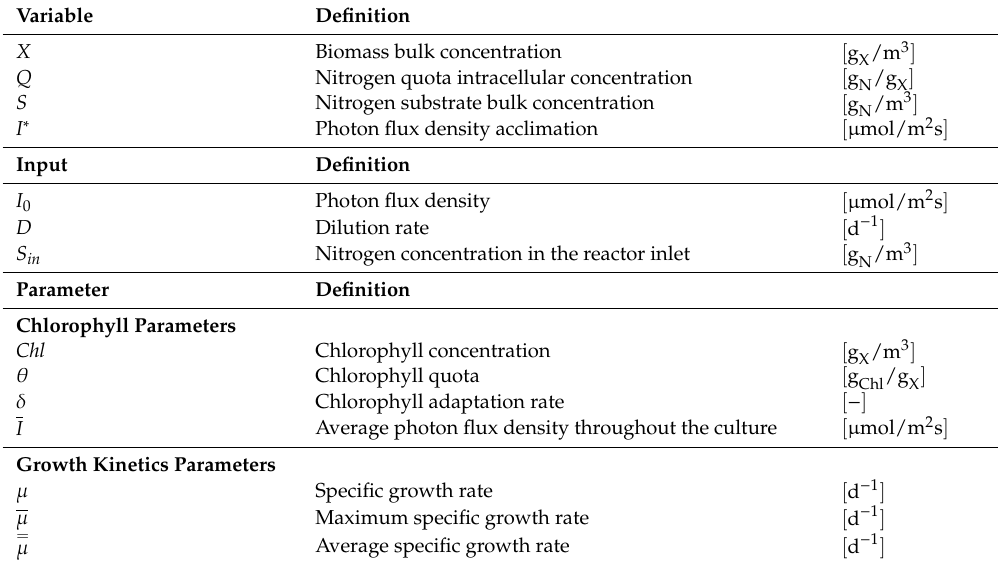
Table A1. Variable and parameter nomenclature